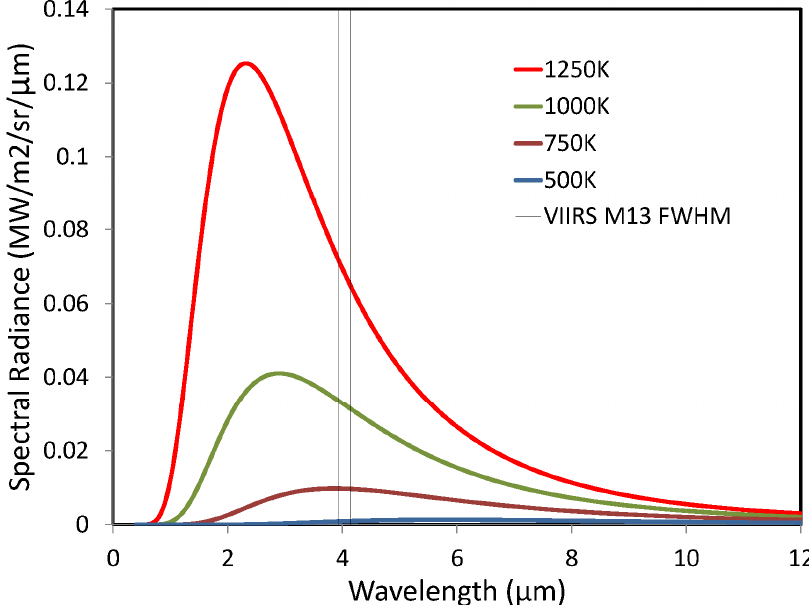
Figure 1. When the hot object fills the entire field of view, the temperature of the object can be estimated based on the radiance observed in a single spectral band that is clear of radiance from external sources. Knowledge of the emissivity of the object and an atmospheric correction can improve the accuracy of the temperature